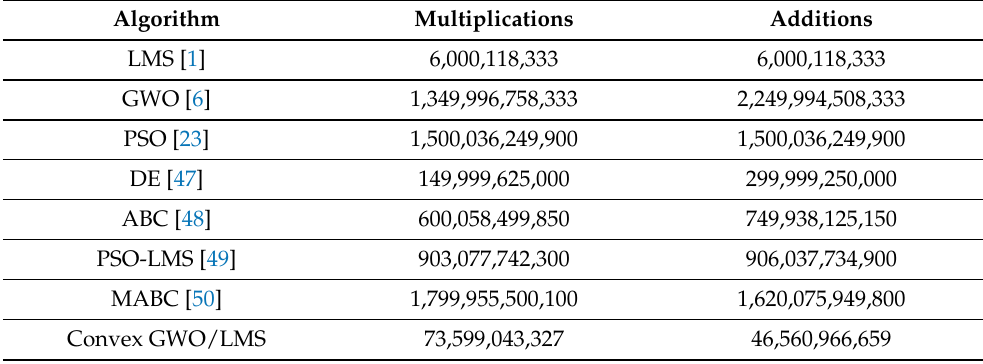
Table 1. Comparison between the proposed convex GWO/LMS system and existing approaches in terms of the number of additions and